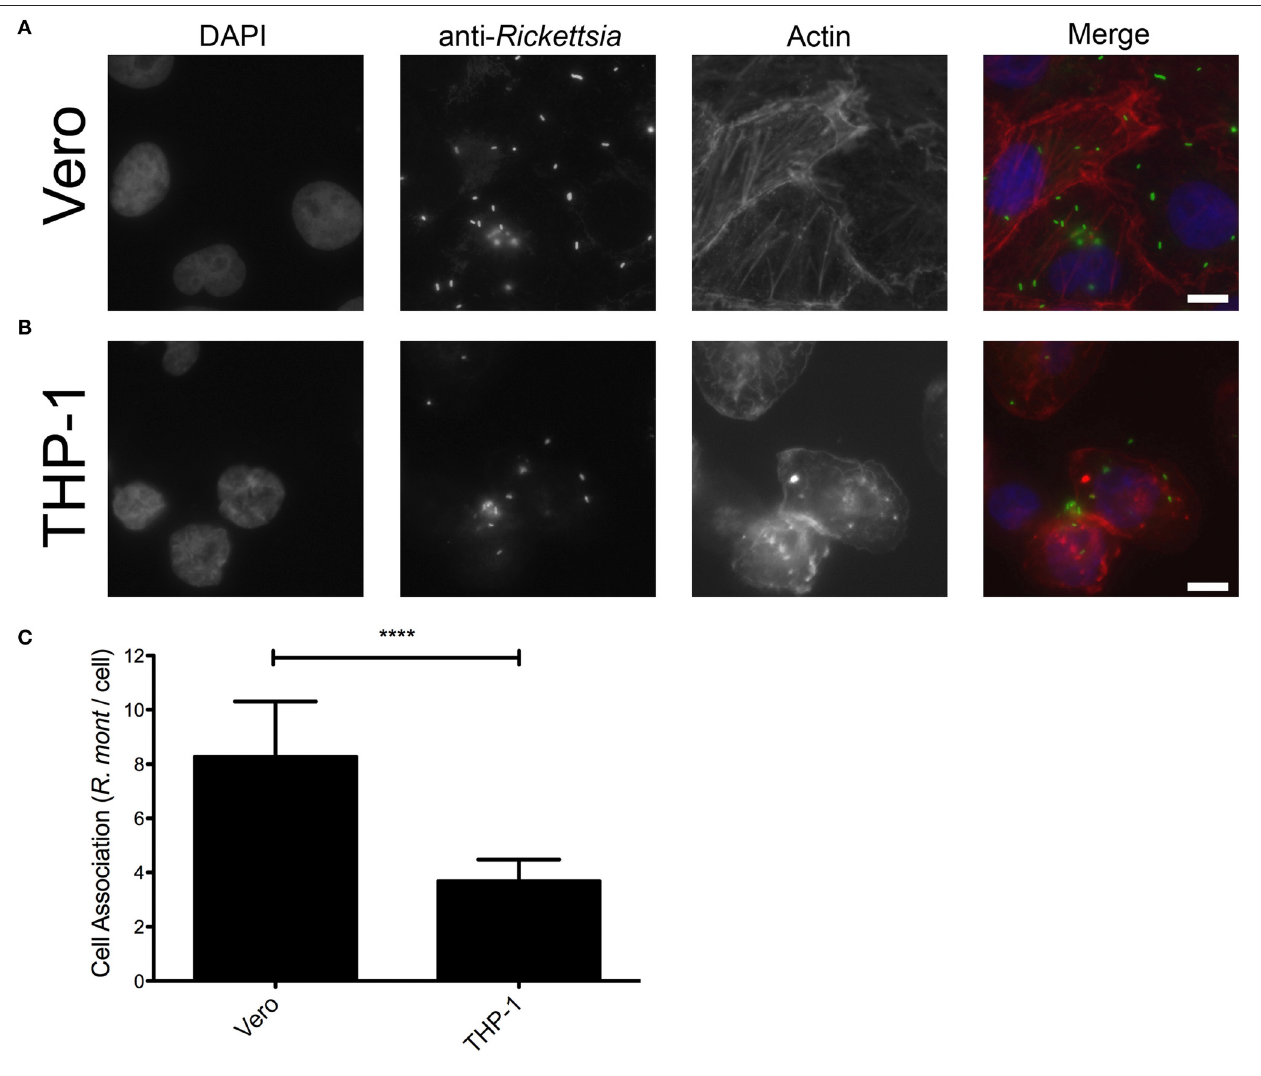
FIGURE 3 | R. montanensis shows a defect in association with THP-1-derived macrophages. PMA-differentiated THP-1 cells and Vero cells were infected with R. montanensis (MOI = 10). After 60 min of infection, cells were fixed and stained for immunofluorescence analysis with rabbit anti- Rickettsia polyclonal antibody (NIH/RML I7198), followed by Alexa Fluor 488 (green) to stain R. montanensis , DAPI to visualize the host nuclei (blue) and Phalloidin to illustrate the host cytoplasm (red). (A , B) Representative immunofluorescence images of R. montanensis association assays in Vero (A) and macrophage-like (B) cells. Each row shows, from left to right nuclei staining, rickettsia staining, actin staining, and the merged image. Scale bar = 10 µ m. (C) Rickettsia and mammalian cells were counted and results are expressed as the ratio of rickettsiae to mammalian cells. At least 200 host nuclei were counted for each experimental condition. Results are shown as the mean ± SD (**** P <